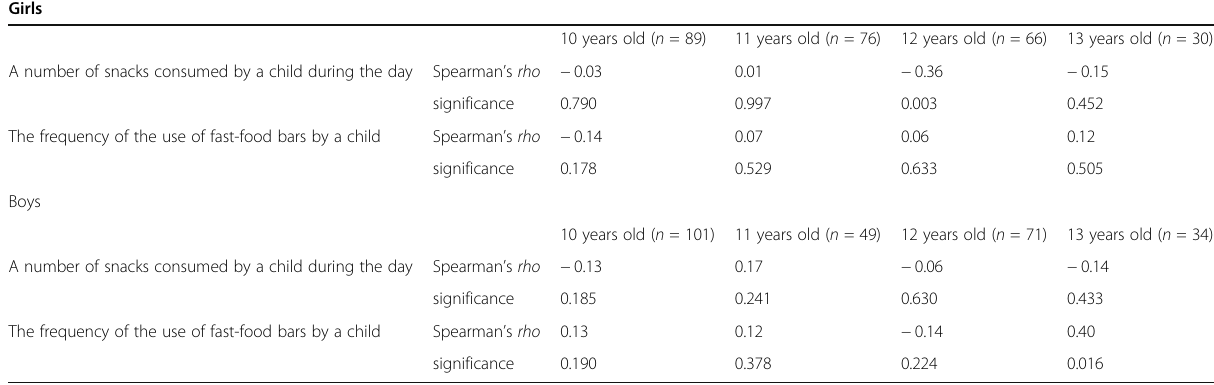
Table 9 The correlation between a number of snacks consumed by a child during the day and the frequency of the use of fast- food bars and BMI depending on age and sex Girls